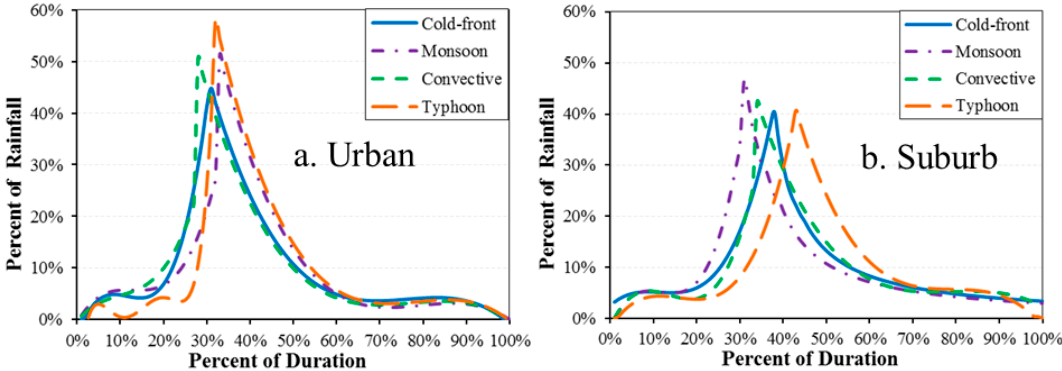
Figure 4. Storm hyetographs derived from the Improved Huff curve model at a probability of 50% from the one minute-interval rainfall data at Sites 1–2 during 2008–2012, and Sites 3–6 from 2014–2017 for the cold-front storms, monsoon storms, convective storms, and typhoon storms in ( a ) urban and ( b ) suburban areas. Table 2. Statistics of storm events for the one minute-interval data during 2008–2012 (Sites 1–2) and 2014–2017 (Sites 3–6). The peak rainfall time is determined using the maximum five-minute rainfall accumulation. The rainfall time is normalized using the total rainfall duration.